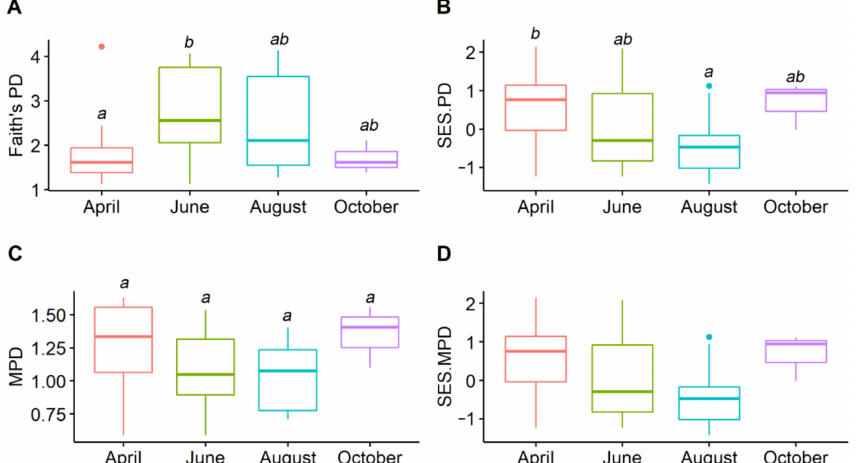
Figure 3. Amphibian phylogenetic structures between four months in montane streams. ( A ) Faith’s PD, ( B ) SES.PD (standardized effect size of Faith’s PD), ( C ) MPD (mean pairwise phylogenetic distance index), ( D ) SES.MPD (standardized effect size of MPD). Different letters on top of the error bars indicate a significant difference between pairwise seasons.